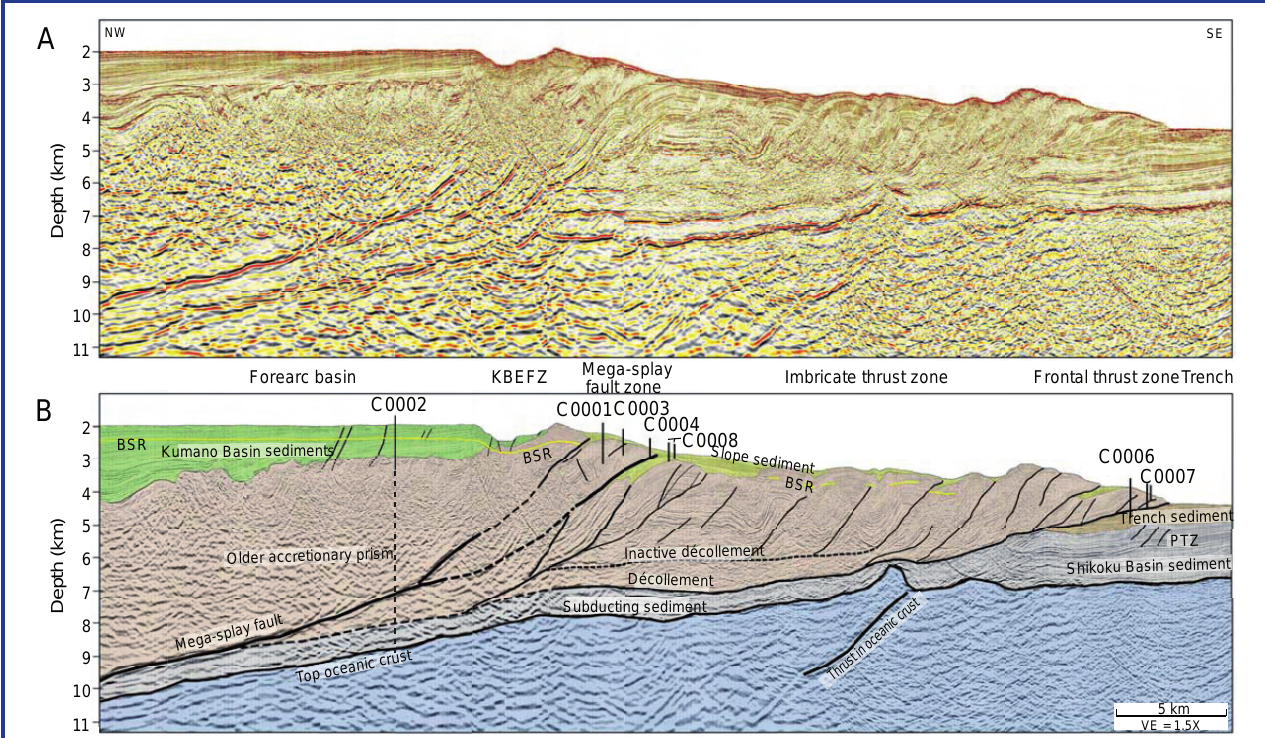
Figure 2. [A] Uninterpreted depth section, processed with pre-stack depth migration. [B] Interpreted version. Only a few representative faults are shown; dashed lines indicate less certain fault locations. Morpho-tectonic zones are shown between the two sections. Composite seismic line extracted from 3-D seismic volume, reproduced from Moore et al., (2009). The line crosses through (or near) all Stage 1 drill sites (solid vertical lines); location shown in Fig. 1. Location of planned Stage 3 ultra-deep drilling at Site C0002 is indicated by dashed vertical line. KBEFZ = Kumano Basin edge fault zone; PTZ = Protothrust zone; BSR=Bottom simulating reflection; VE = Vertical